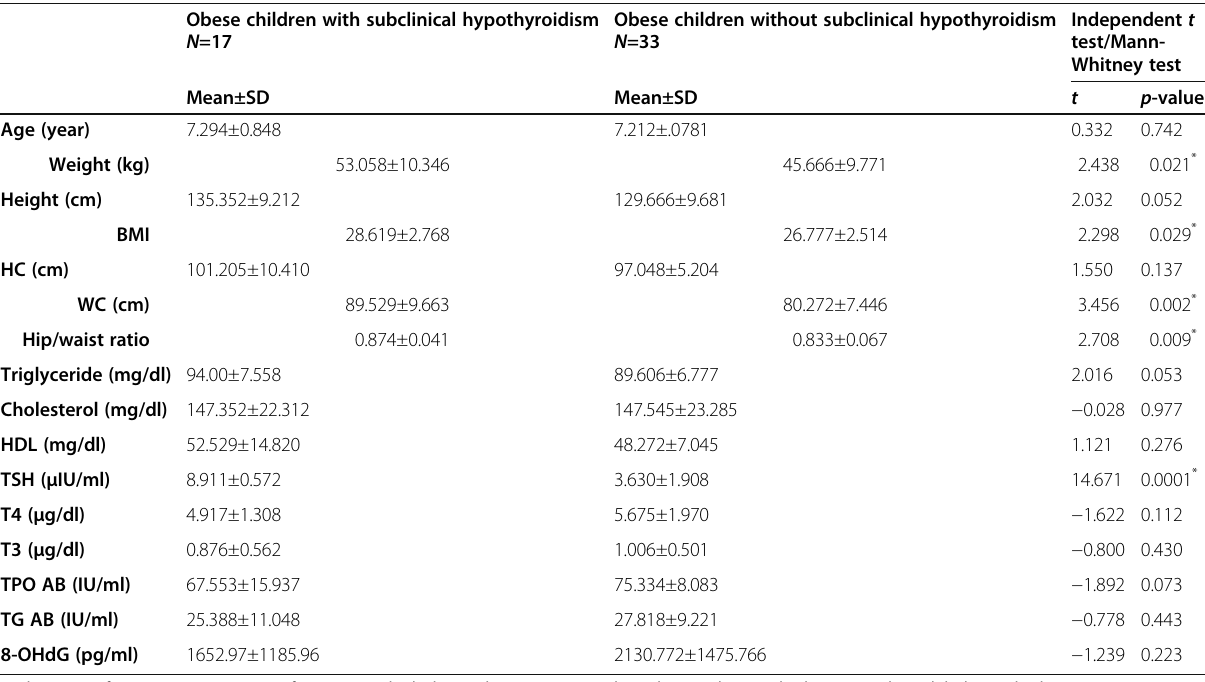
Table 2 Comparison of clinical data, thyroid function, lipid profile, and oxidative DNA damage in relation to subclinical hypothyroidism in children with obesity Obese children with subclinical hypothyroidism N =17